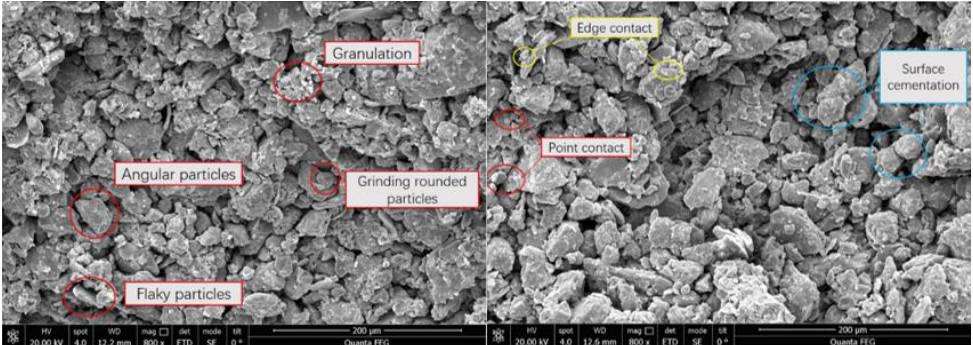
Figure 5. Loess particle morphology and connection method.